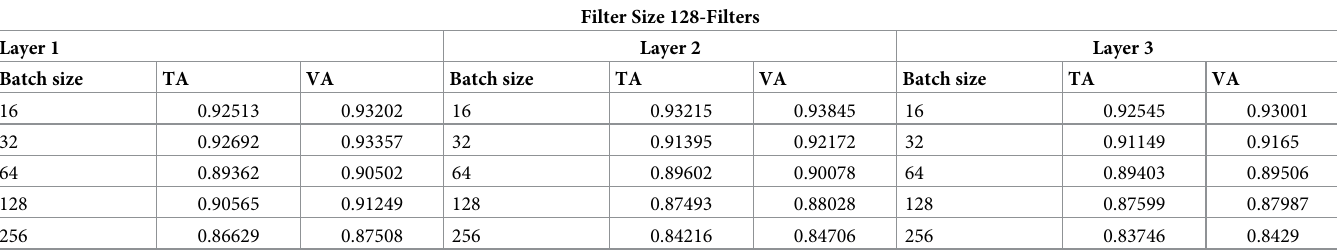
Table 6. Experimentation results of LSTM with